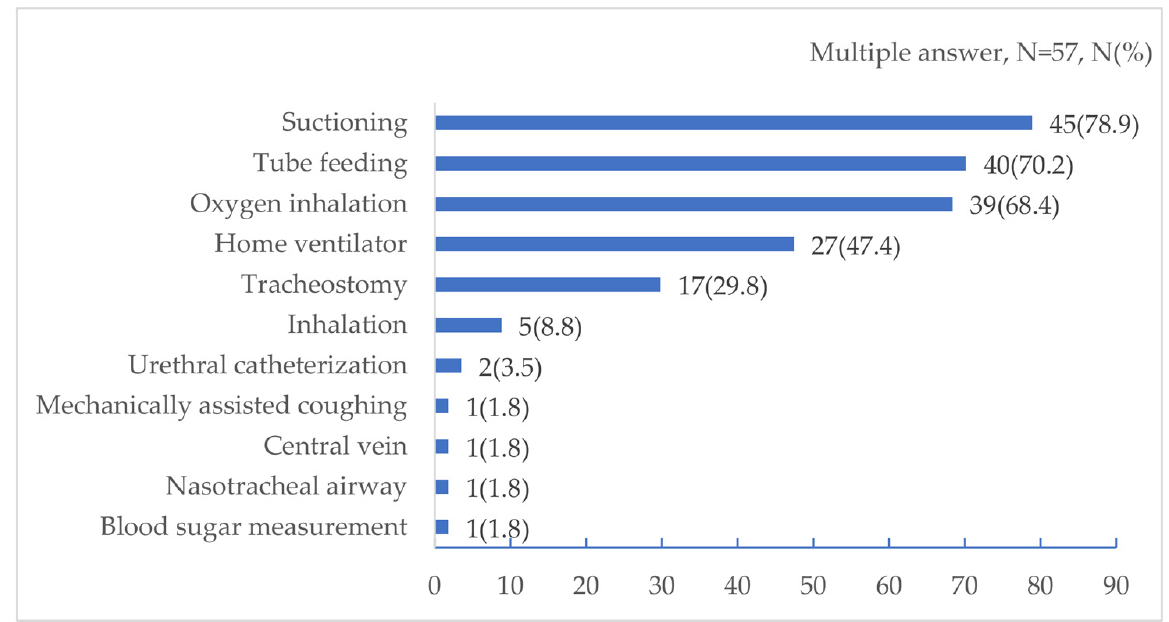
Figure 1. Medical devices and procedures required by the pediatric patients in this study.